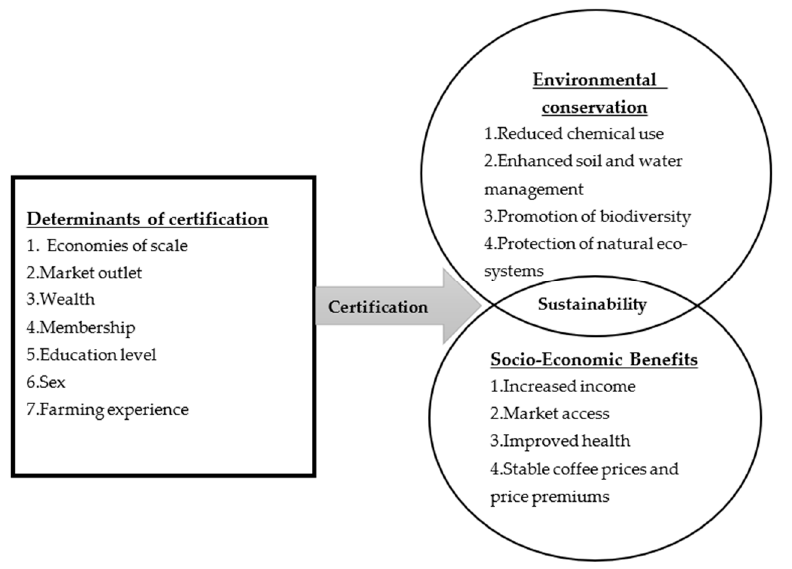
Figure 4. Conceptual framework. Source: adapted from Rosen and Kishawy [9] and Pyk and Hatab [7].